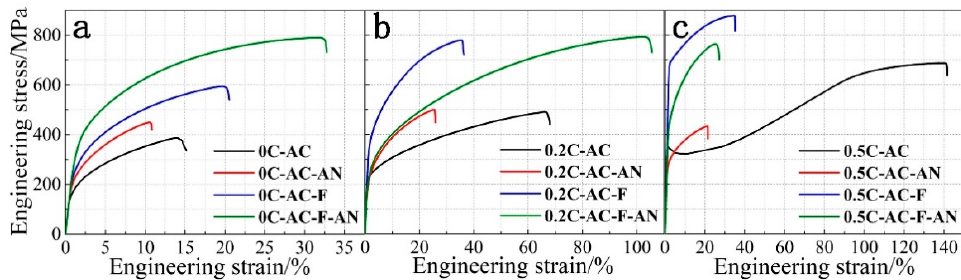
Figure 10. Engineering stress–strain curves of the specimens with different carbon contents under different heat treatment states; ( a ) with 0% carbon content; ( b ) with 0.2% carbon content; ( c ) with 0.5% carbon content.